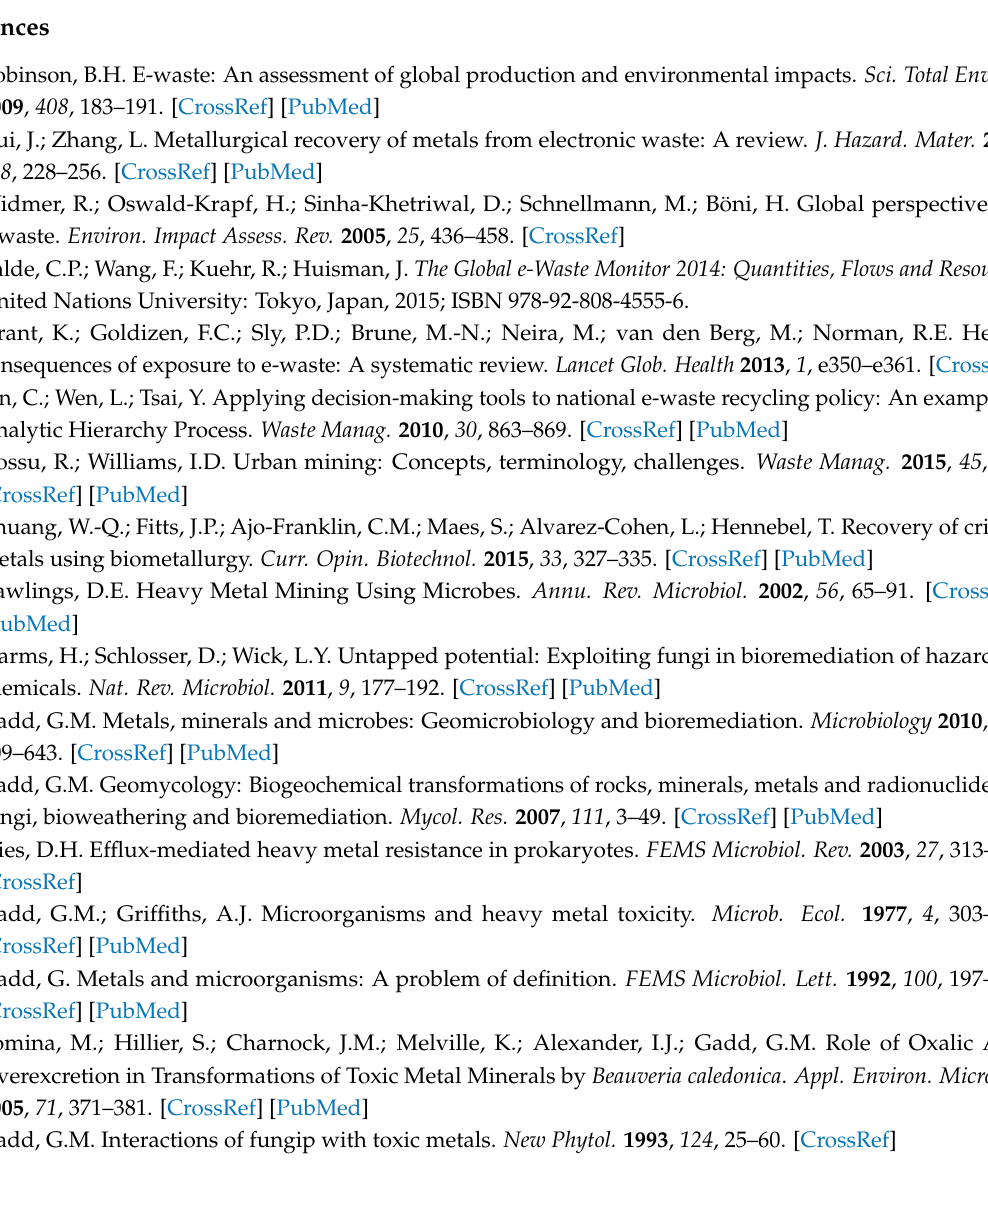
pH indicator). Co-cultures of ( A ) B. exigua and Pseudomonas sp. ( B ) T. rossicum and S. ureilytica Lr